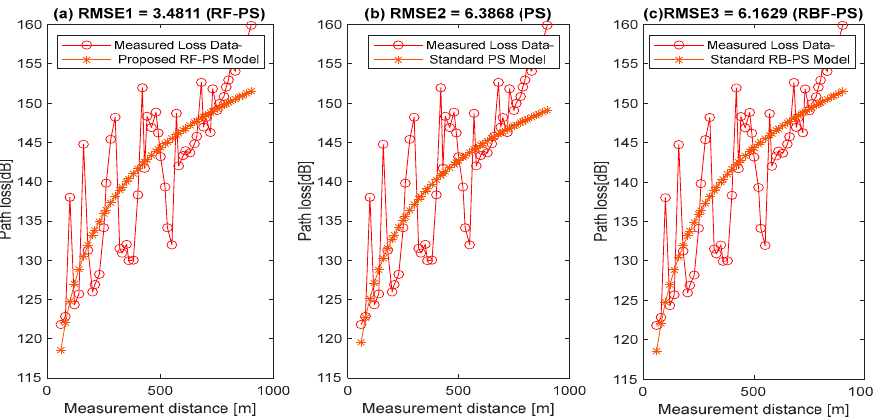
Figure 18. Results showing the measured path loss versus distance using the hybrid RF-PS method and two existing standard path loss prediction methods in site 2 of location 4.